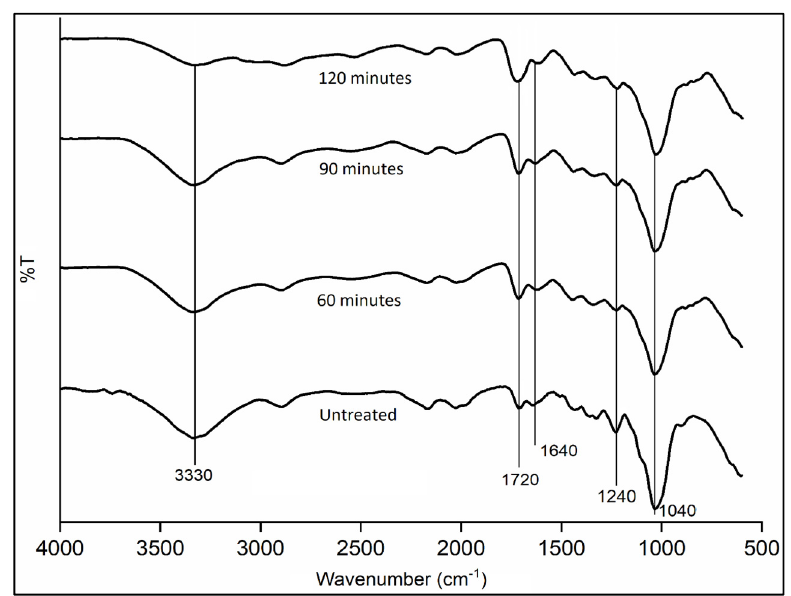
Figure 6. FTIR spectra for MA-treated KBF at different treatment time.